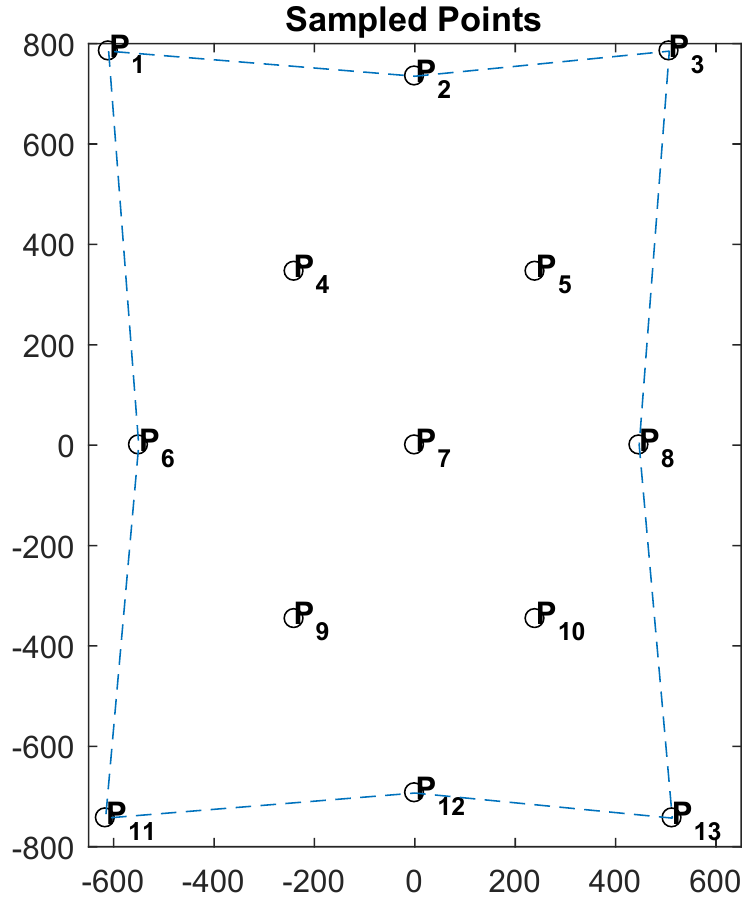
Figure 2. Thirteen initial data points (fitting model) of the vehicle